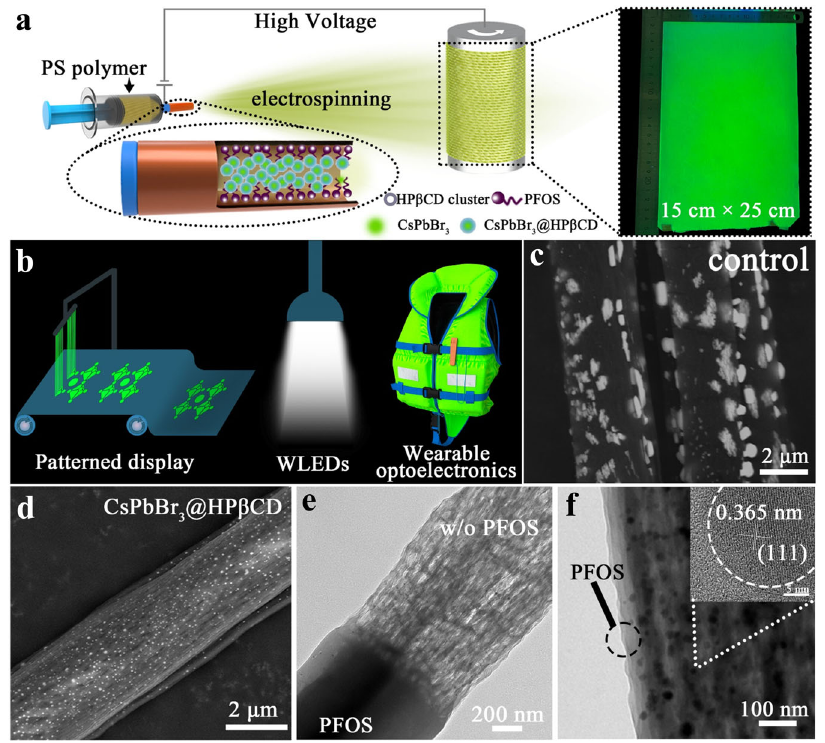
Fig. 1 | Schematic illustration of the fabrication process of PLTs and morpho- logical characterization. a Schematic illustration of the fabrication process of PLTs and the as-prepared fi brous membrane under UV light irradiation. b Application of CsPbBr 3 @HP β CD@PFOS composites in patterned display, white light-emitting diodes (WLEDs) and wearable optoelectronics. SEM (YAG back-scattered